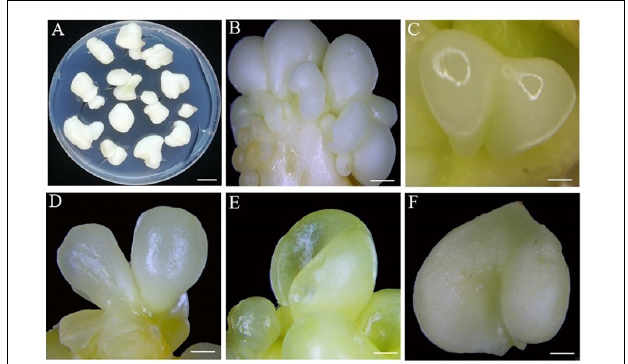
FIGURE 4 | The observation of direct somatic embryogenesis pathway at different developmental stages. (A) 30 days after inoculation. (B) Globular embryo 50 days after inoculation. (C) Heart embryo 55 days after inoculation. (D) Torpedo embryo 60 days after inoculation. (E) Cotyledonary embryo 65 days after inoculation. (F) Mature cotyledonary embryo 80 days after inoculation. Bars: (A) = 2 mm, (B–D) = 1 mm, and (E,F) = 4 mm.